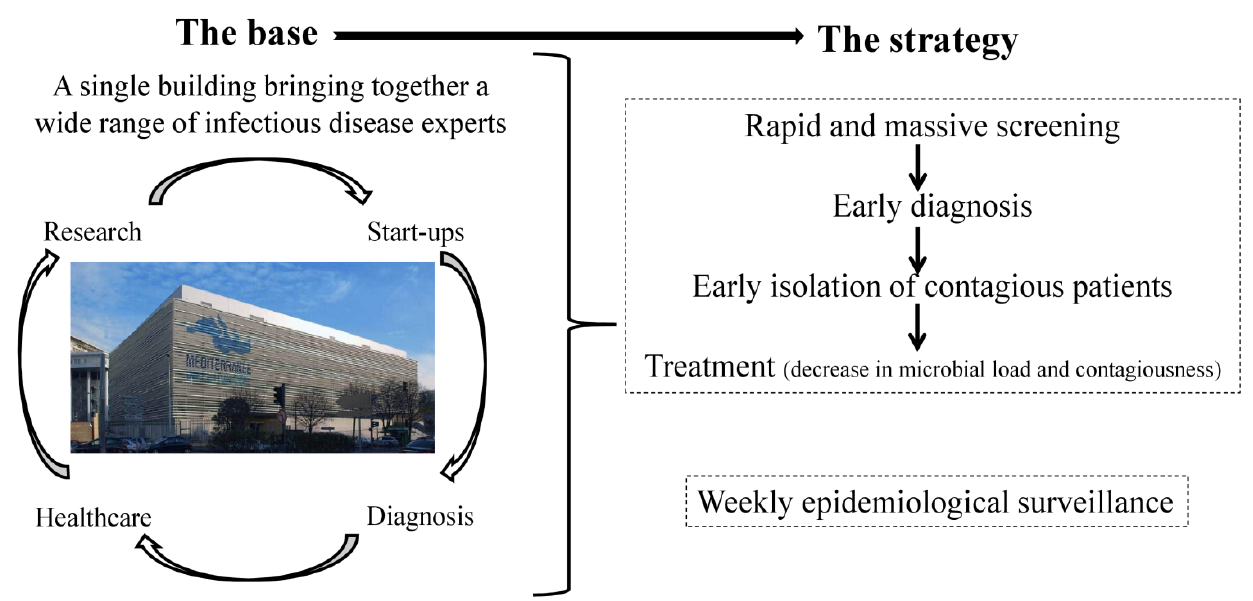
Figure 1. The base and the strategy of contagion management at the IHU.